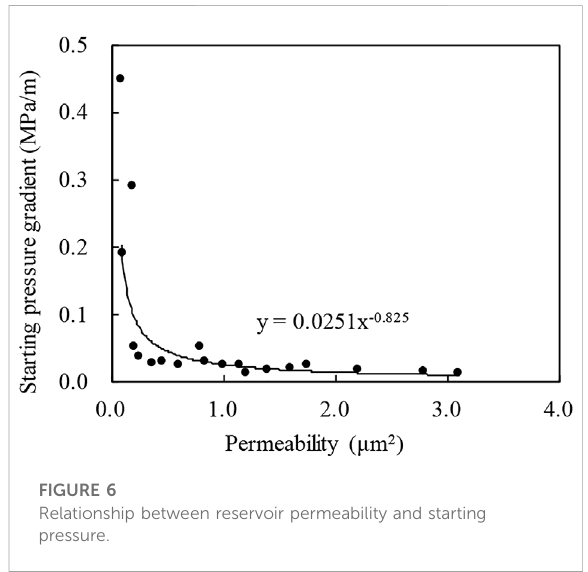
FIGURE 8 Formation pressure distribution plan of fracturing well volume fracturing horizontal